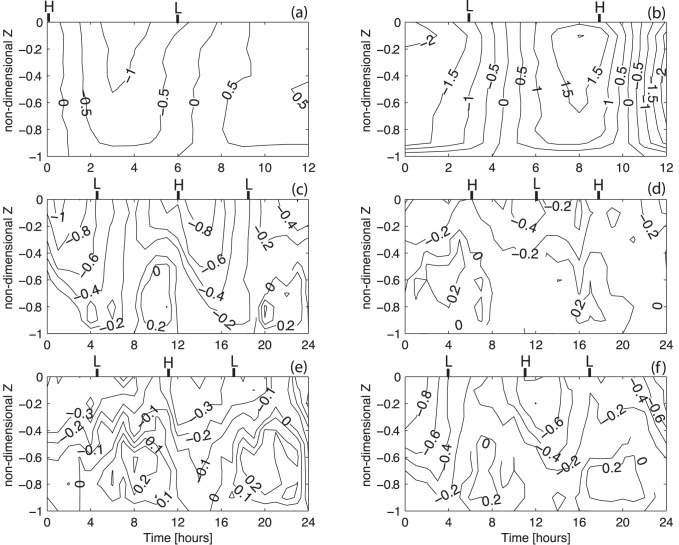
Contour figures of longitudinal velocity component as a function of the depth (Z) and time for all survey periods.
H and L indicate the local high and low-water. (a) 21/02/2002 (station A); (b) 28/02/2002 (station A); (c) 15/01/2004 (station B); (d) 16/06/2004 (station B); (e) 27/08/2004 (station B); (f) 03/12/2004 (station B).